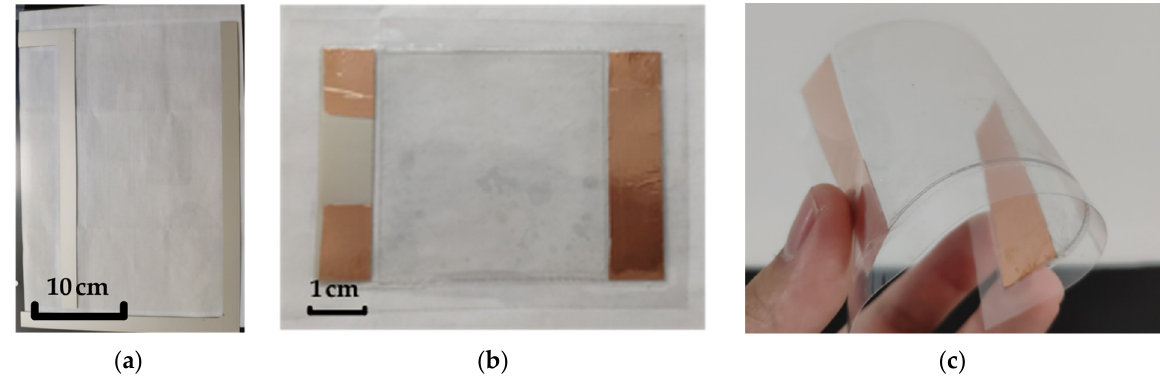
Figure 3. ( a ) The adopted CVD graphene grown on PET film; ( b ) the fabricated GIG sample (8 × 8 cm); ( c ) GIG sample bent at a certain angle.